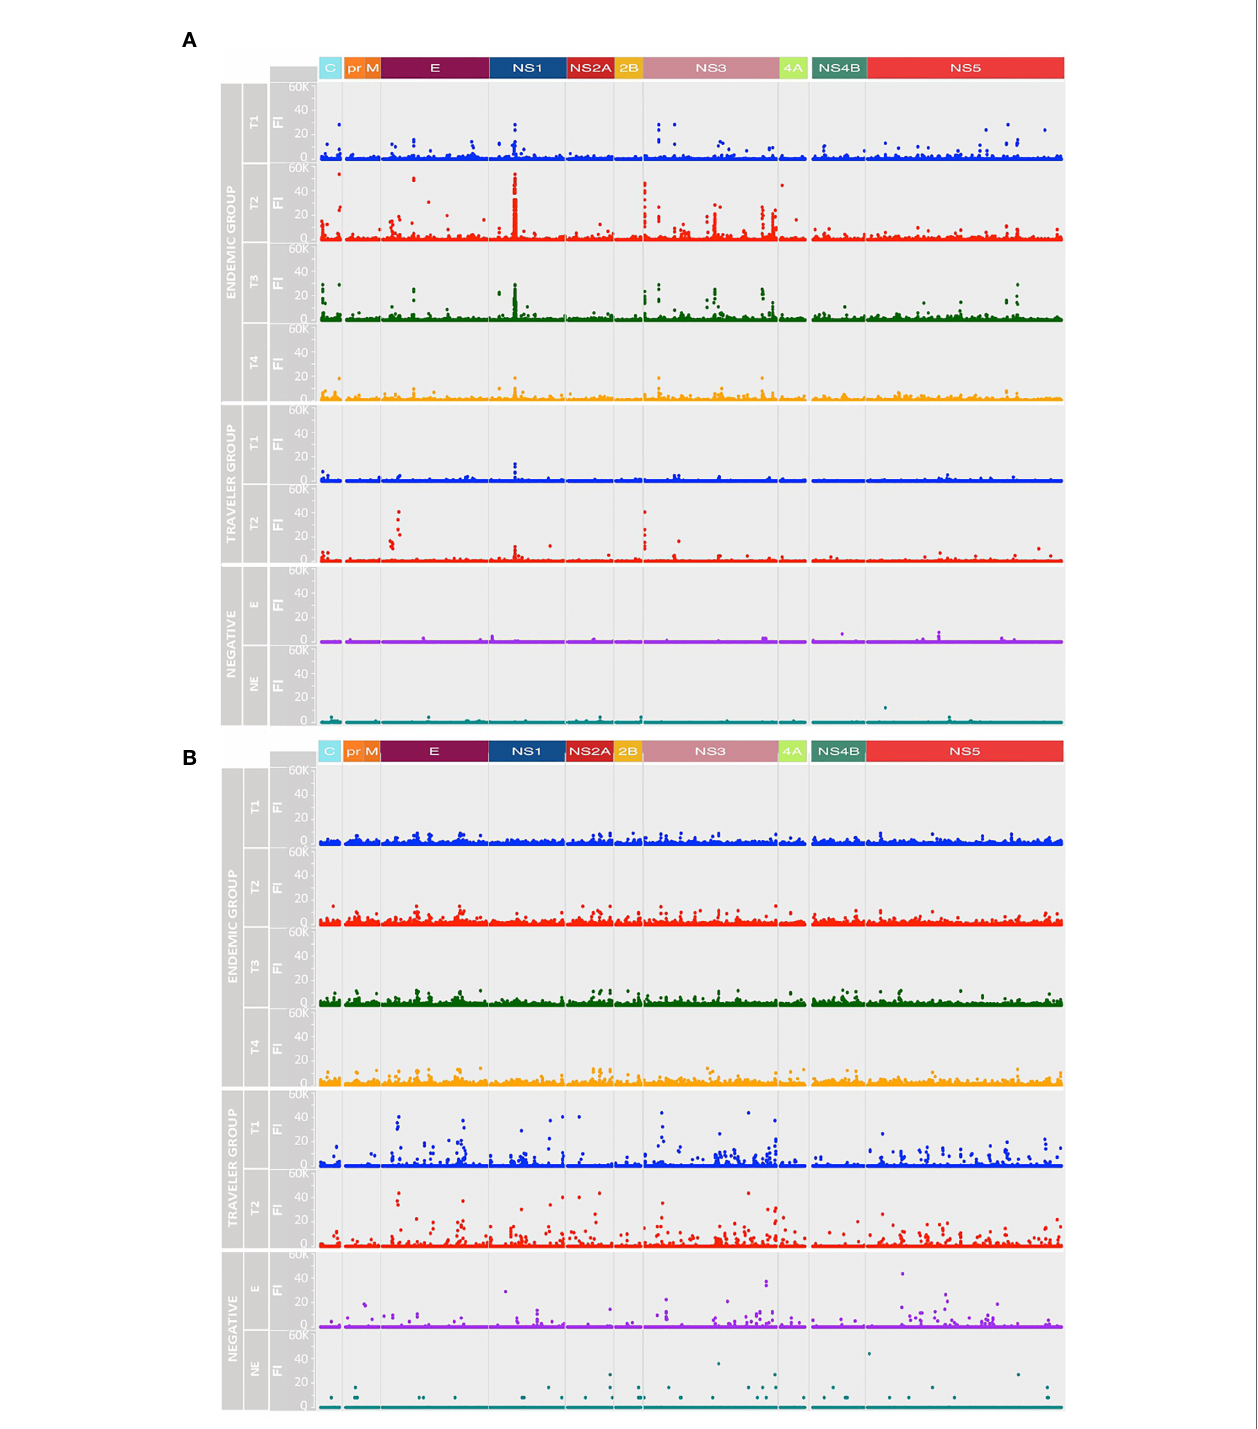
FIGURE 3 | Longitudinal humoral responses to linear epitopes covering the DENV proteome. The plots show the level of IgG (A) and IgM (B) Ab reactivity measured in fl uorescence units relative to proteomic coordinates for DENV (Uniprot ref: P33478). Structural: Capsid (C), Membrane (pr, M) and Envelope (E), and non-structural proteins: NS1, NS2A, NS2B, NS3, NS4A, NS4B and NS5 are color represented; each dot represents the Ab binding to a single peptide in the microarray. In both A and B plots, the endemic group is at the top (four-time points), the traveler group at the center (two-time points) and the negatives at the bottom (one-time point). T1: acute (blue dots), T2: early convalescent (red dots), T3: mid convalescent (green dots) and T4: late convalescent (orange dots) samples. Responses from the endemic (E) and non-endemic (NE) negatives are represented in purple and cyan dots,